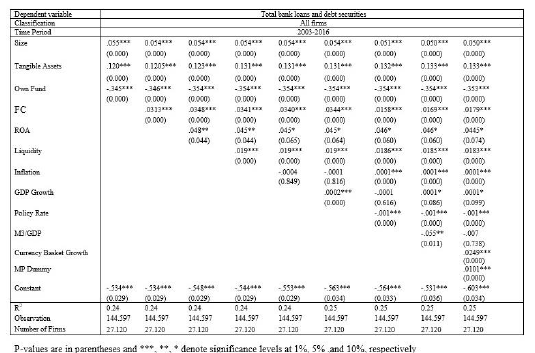
Table 5: Fixed Effect Analysis on Financial Debt with Additional Macro Variables